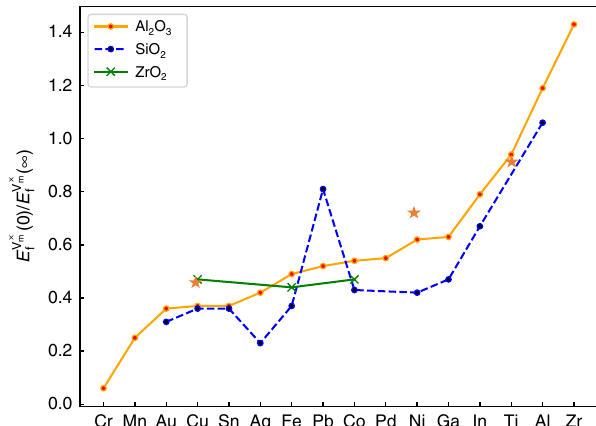
Fig. 5 The predicted ratio of the vacancy formation energies at the metal/ ceramic interface to that in the bulk metal for several metal/ceramic systems according to Eq. (1). The values for γ m and W ad are from 47 – 52 . The metals are indicated along the horizontal axis and different ceramics by the three curves. The Ni/Al 2 O 3 , Cu/Al 2 O 3 , and Ti/Al 2 O 3 data (orange stars) are from direct DFT